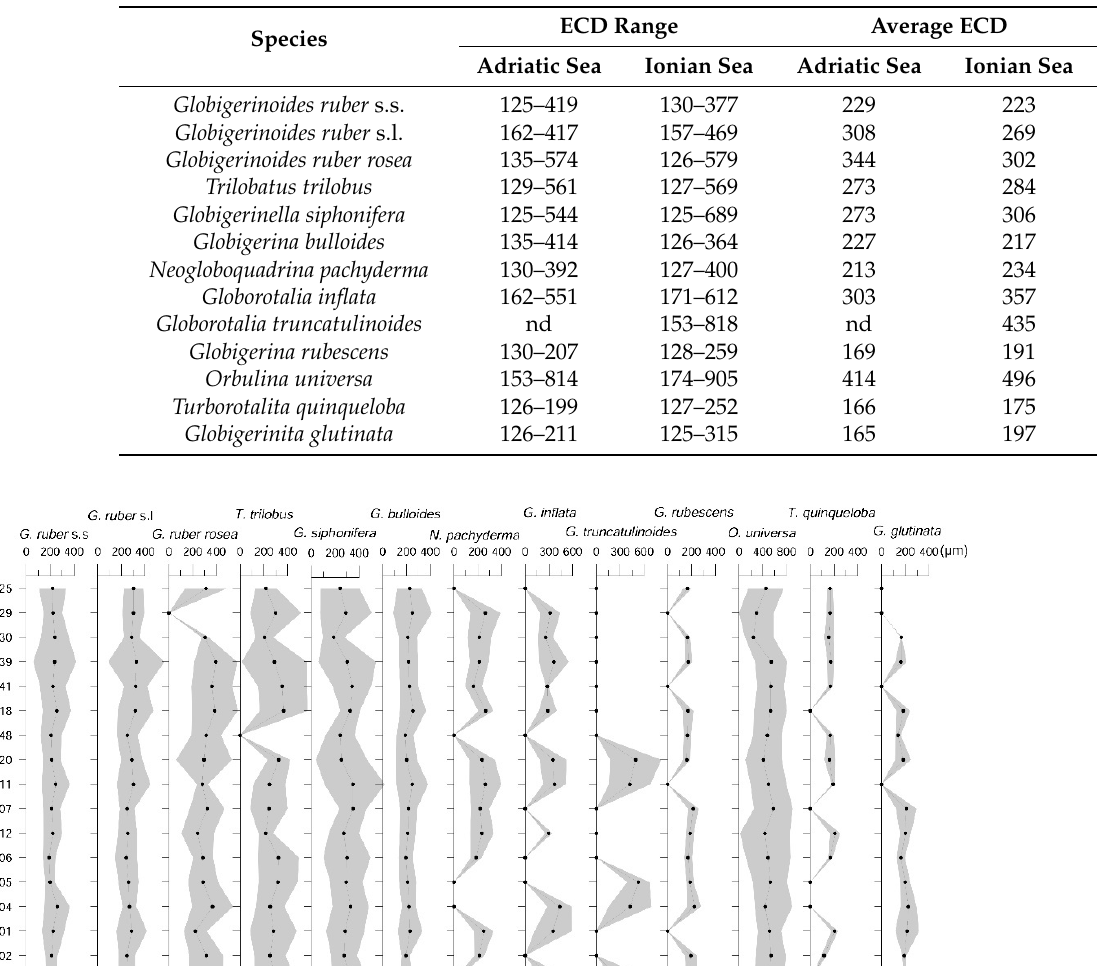
Table 2. Intraspecific ECD ranges and their average values (in μ m) per basin analyzed. nd: not determined.